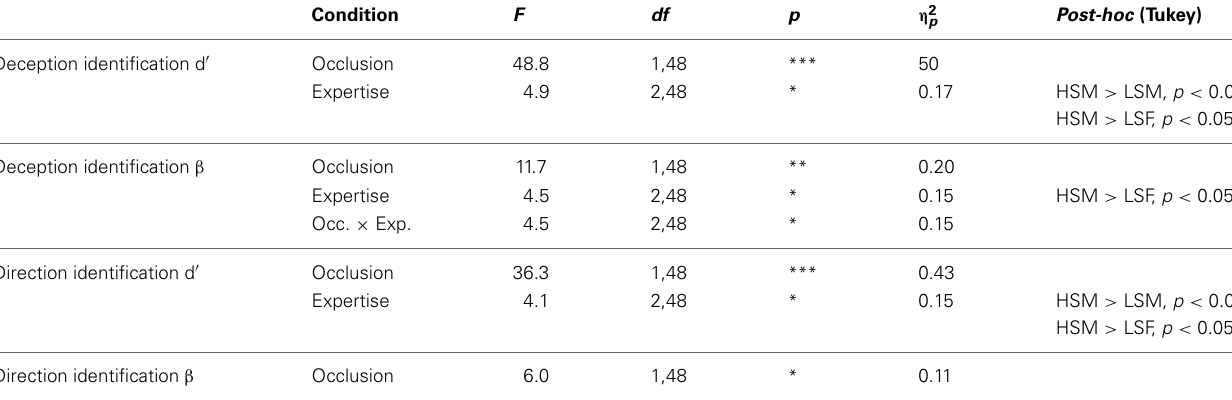
Table 2 | Significant results from ANOVA conducted separately for deception identification and direction